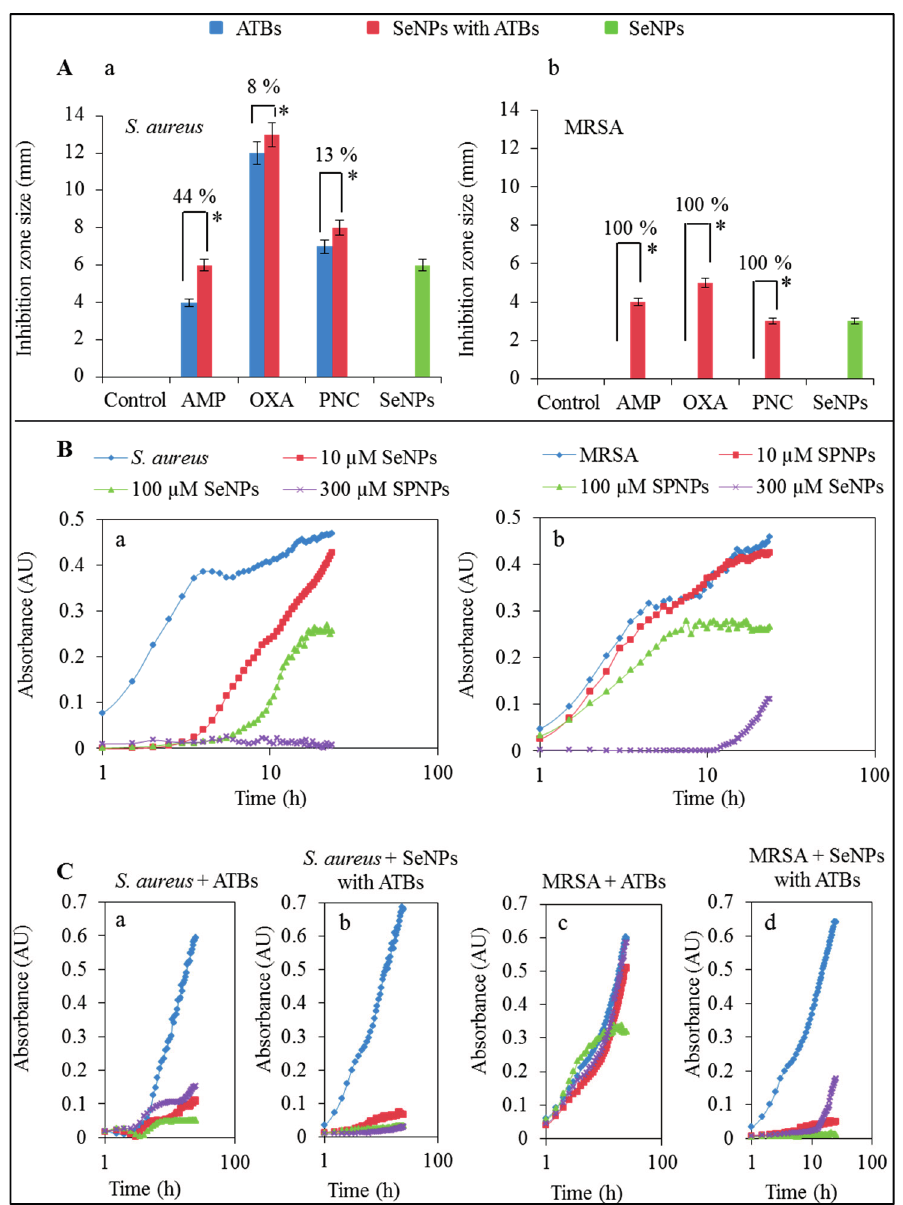
Figure 1. ( A ) Determination of inhibition zones after application of circular discs on the S. aureus ( a ) and MRSA ( b ) strains with 100 µM concentration of ampicillin, oxacillin, penicillin or complexes (100 µM of nanoparticles and 100 µM of ATBs) of SeNPs with ampicillin, SeNPs with oxacillin and SeNPs with penicillin. Cultivation was carried out at 37 °C for 24 h; ( B ) Optimization of SeNPs concentration for non-resistant S. aureus ( a ) and MRSA ( b ) for other measurements; ( C ) Growth curves after application of ATBs (ampicillin—red line, oxacillin-green line, penicillin—purple line) on S. aureus ( a ) and MRSA ( c )—blue line and complexes of SeNPs (100 μ M) with the same ATBs (100 μ M) S. aureus ( b ) and MRSA ( d )—blue line. All data represent mean ± S.D. NS, not significant, * p <